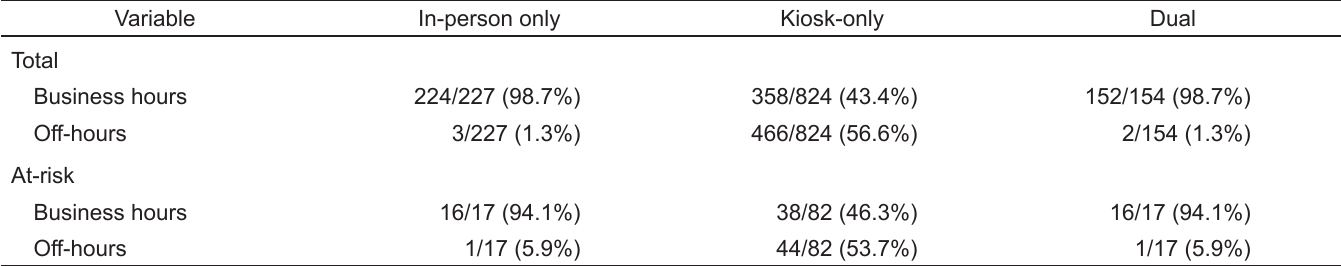
Table 3. Capture of total participants and participants at risk for drug/alcohol disorders by screening modality and time of day.